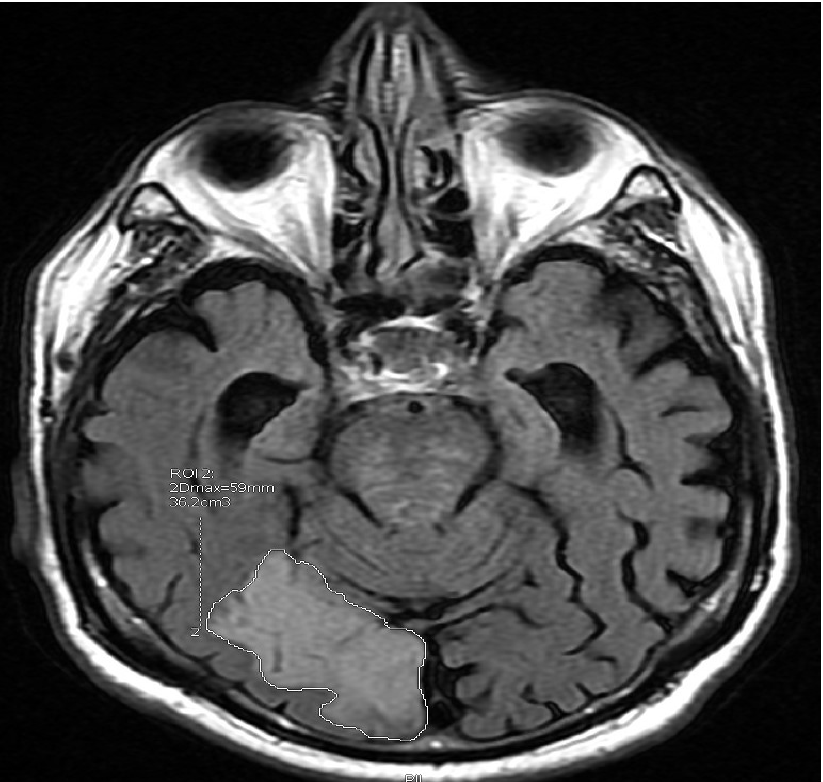
Figure 2. Volumetric evaluation of ischemic focus size in magnetic resonance (MR) in fluid-attenuated inversion recovery (FLAIR) sequence.